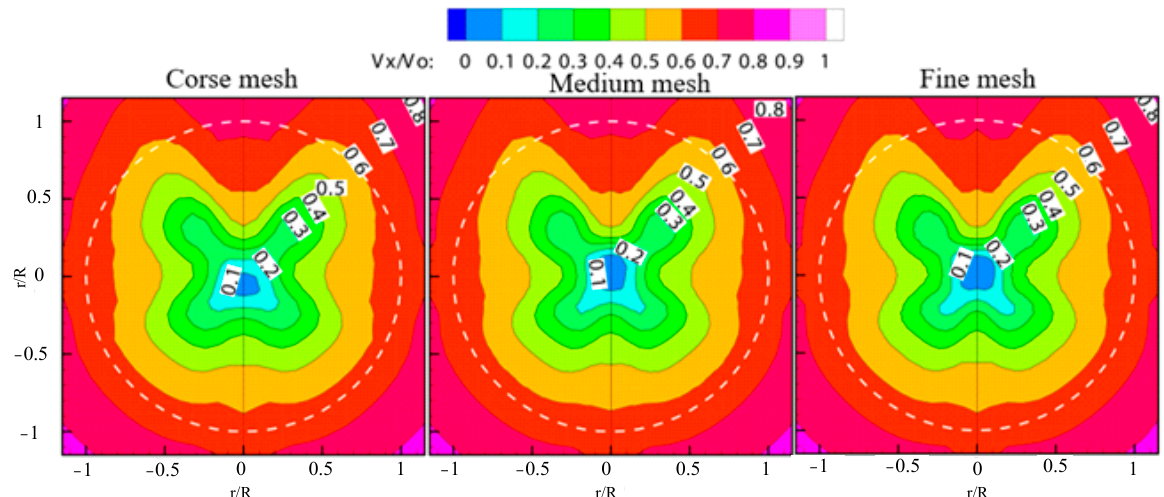
Figure 6. Axial velocity contour with di ff erent grid numbers.